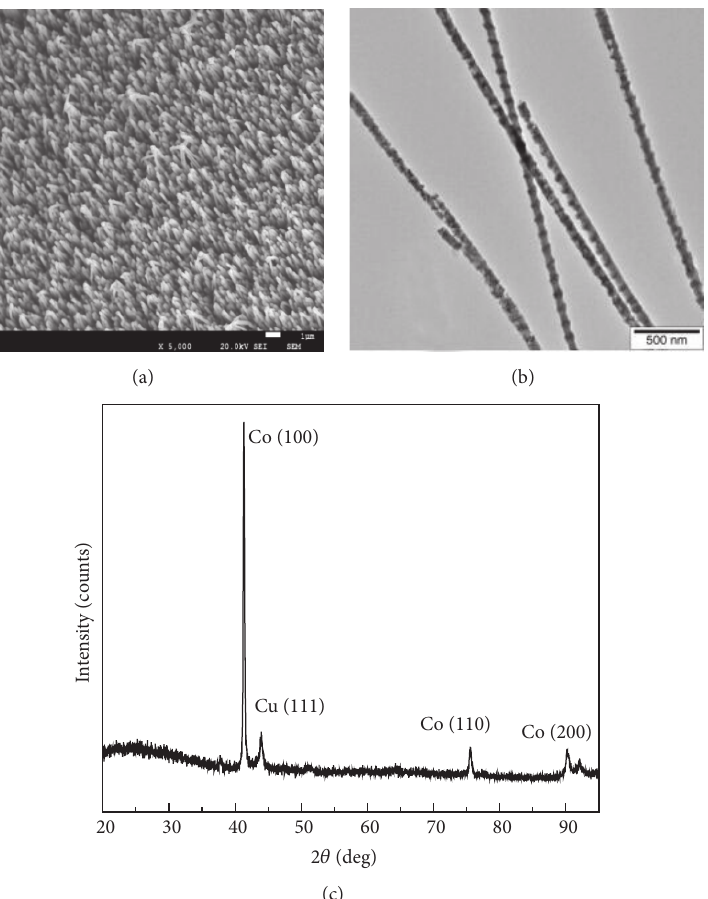
Figure 3: SEM (a), TEM profile image (b), and XRD pattern (c) of the Co (50 nm)/Cu (5nm) nanowires prepared at 𝑡 Co = 2 1s and 𝑡 Cu = 1 7s after removing the PAA